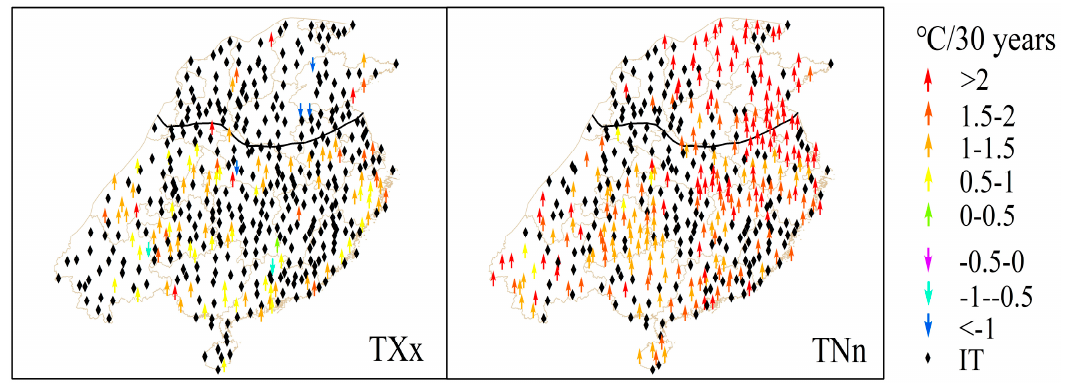
Figure 10. Spatial distributions of the trend magnitudes for TXx and TNn at a 30-year scale during the growth period of October 1961 to May 2016. IT represents insignificant trends, and the trend magnitude fails to pass the significance test of p = 0.05. The colored arrows indicate that the trend magnitude has passed the significance test of p = 0.05.